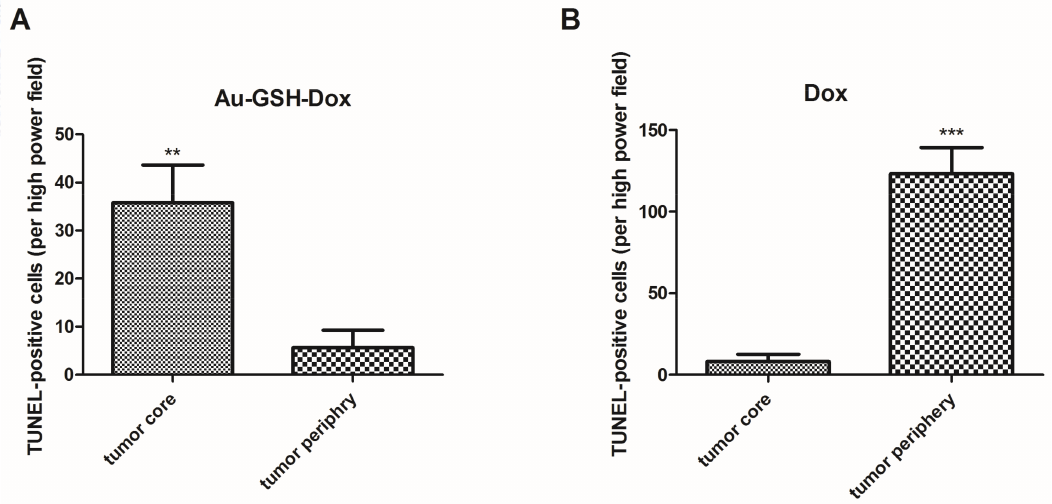
Figure 11. Statistical analysis of TUNEL-positive cells per HPF in the tumor core and periphery of tumors after six injections of Au-GSH-Dox ( A ) and Dox alone ( B ). Results are presented as the mean with SEM. p ≤ 0.01 is marked with **, while p ≤ 0.001 is marked with ***. Tumor progression was visible after treatment with test compounds within all groups (Figure 12). FISS enlarged their volume 36-, 48-, 24- and 20-times within 14 days of treatment with NaCl,